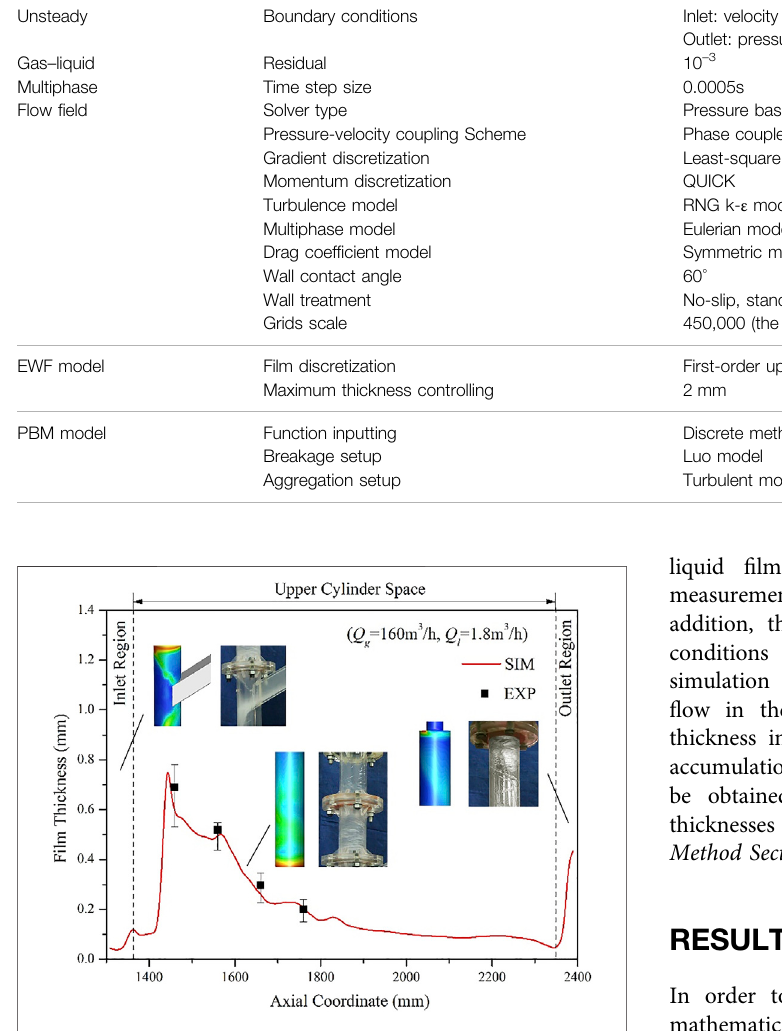
FIGURE 5 | Veri fi cation of fi lm thickness along the axial direction of GLCC cylinder.